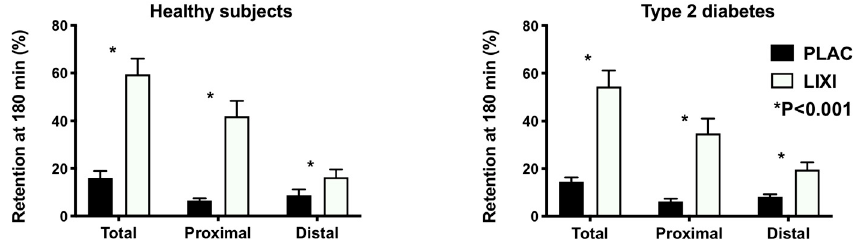
Figure 1. Intragastric distribution of gastric content (retention in the total, proximal, and distal stomach regions) at t = 180 min following a 75-g glucose drink radiolabelled with 20 MBq 99m Tc-Calcium Phytate in health and type 2 diabetes (T2D) following lixisenatide (10 mcg sc) or placebo (sc). p < 0.001 treatment difference in two-way repeated measures ANOVA. Treatment-by-group interactions all nonsignificant ( p > 0.05).